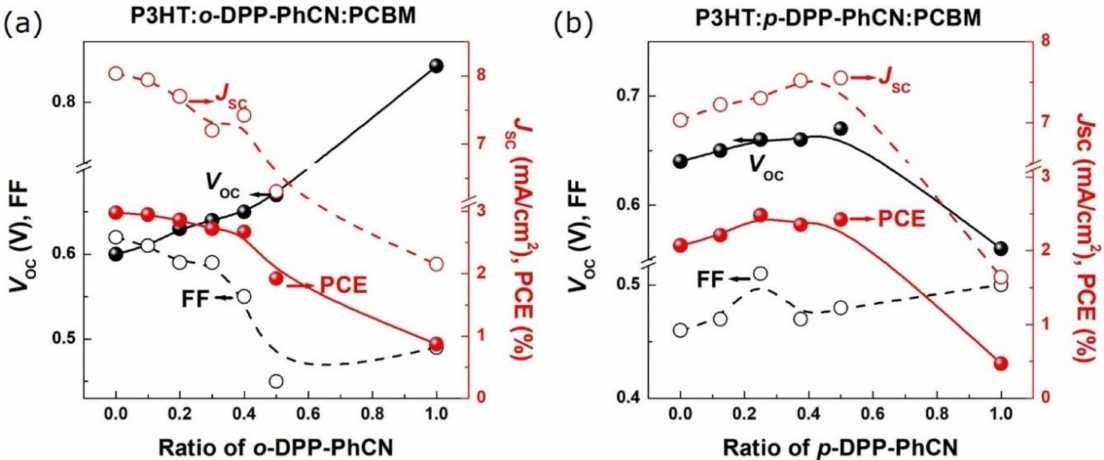
Figure 5. Dependence of the photovoltaic performance of ternary cells on the ( a ) o -DPP-PhCN and ( b ) p -DPP-PhCN blend